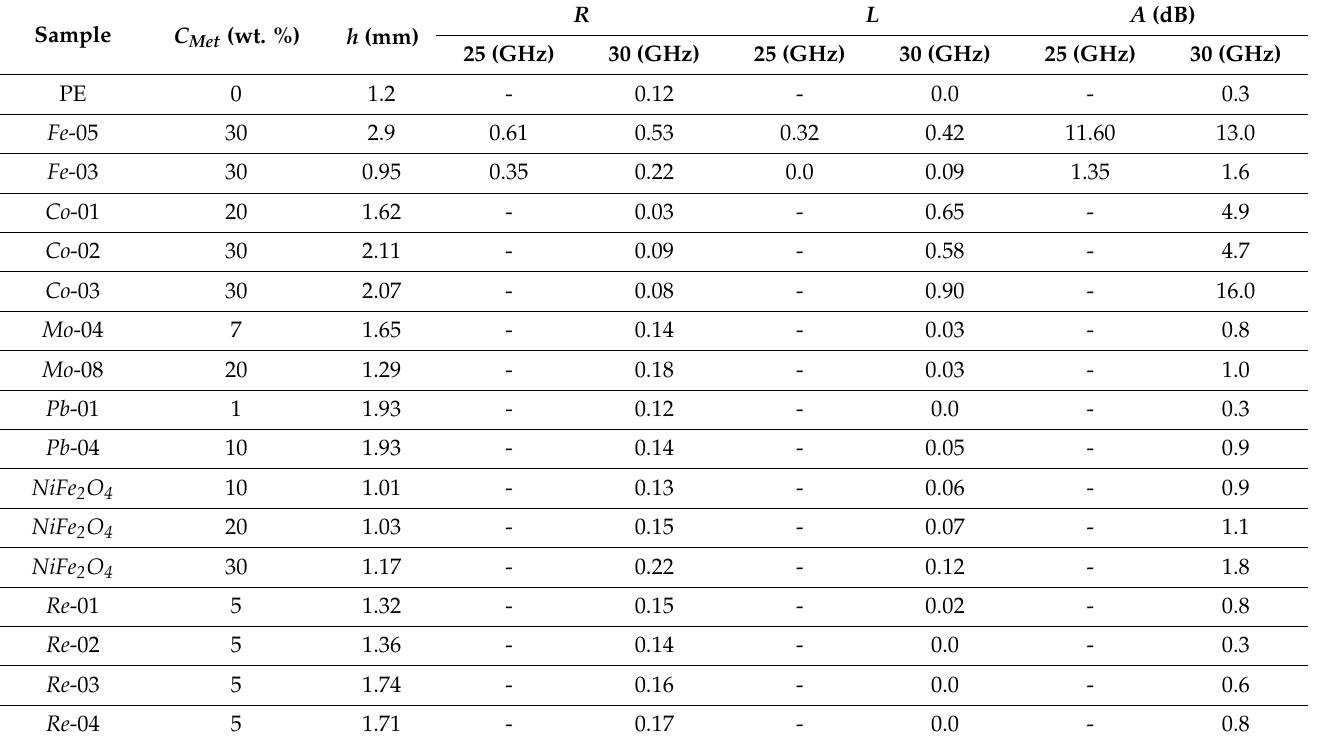
Table 17. Attenuation, reflection, and loss coefficients in the microwave range for composites on metal-containing nanoparticles and HPPE